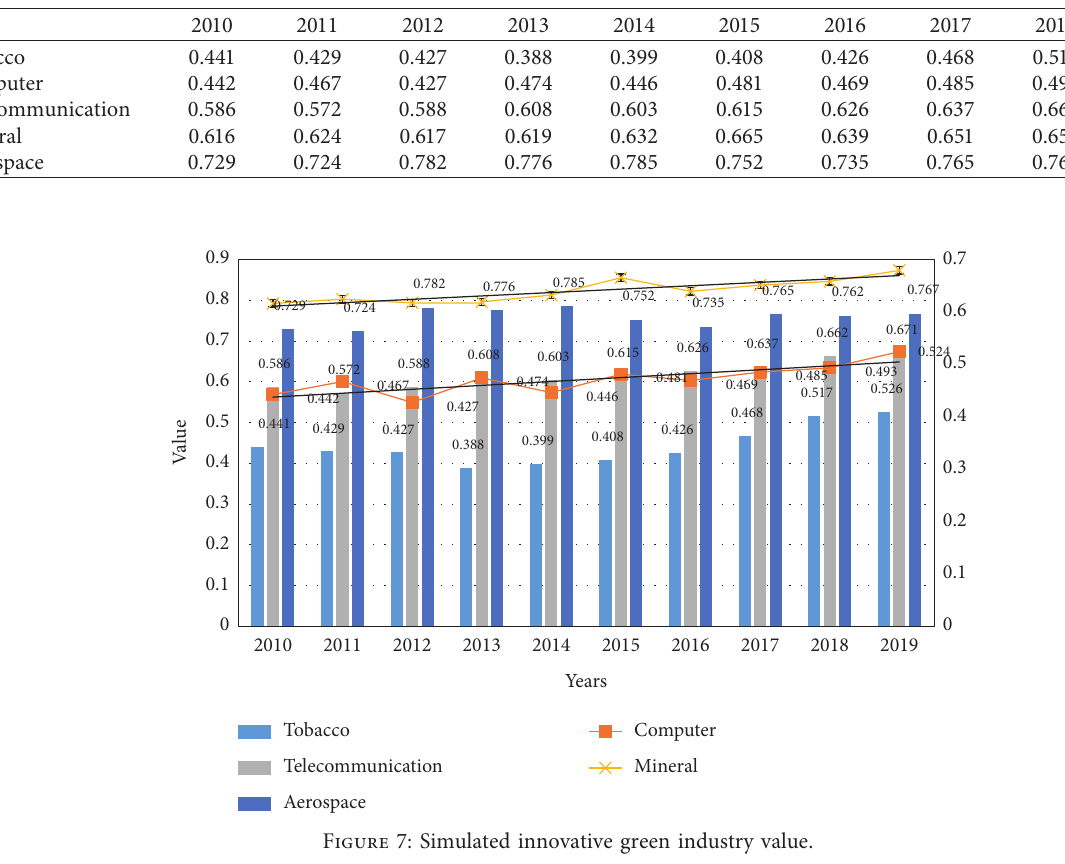
Table 5: Innovative changes under a complex adaptive system.